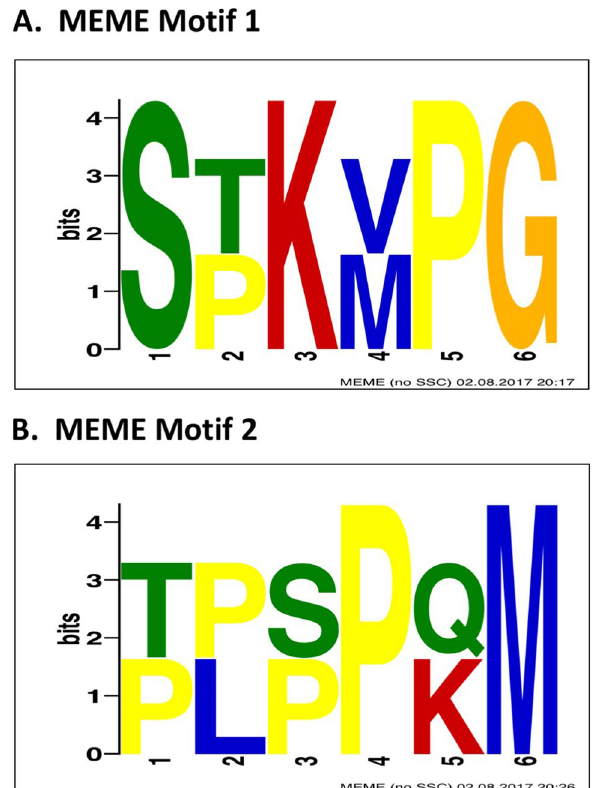
Figure 1. The motifs identified by MEME analysis in the nine peptides for which transport data were obtained ( A . Motif 1), and analysis limited to the five peptides with the highest transport rates ( B . Motif 2). These motifs highlight the importance of a central lysine (K) or proline (P) in the